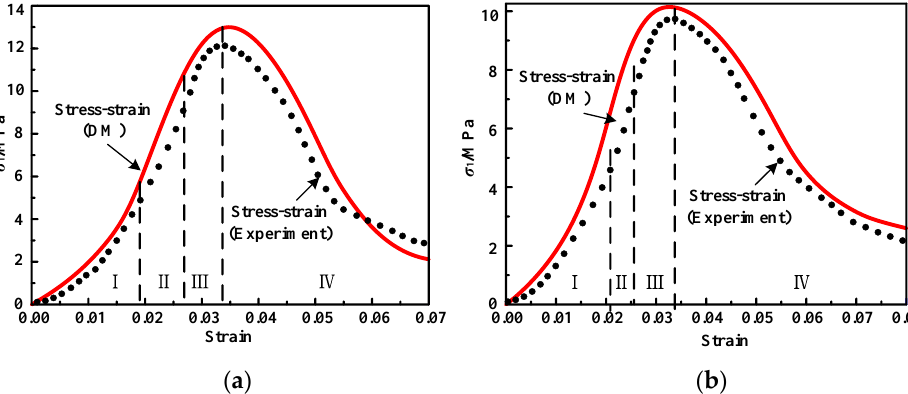
Figure 11. Comparison between experimental and theoretical curves of cement mortar: ( a ) cement – ratio of 1:1 and loading rate of 0.1 mm / min; ( b ) cement–sand ratio of 1:2 and loading rate of 1.0 mm / sand ratio of 1:1 and loading rate of 0.1 mm/min; ( b ) cement – sand ratio of 1:2 and loading rate of 1.0 mm/min.